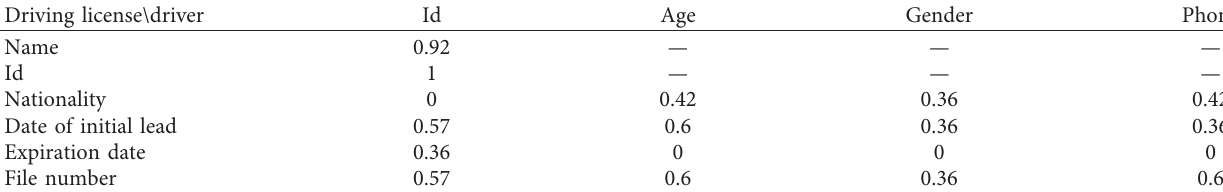
Table 9: Matching between attributes, Set 4.